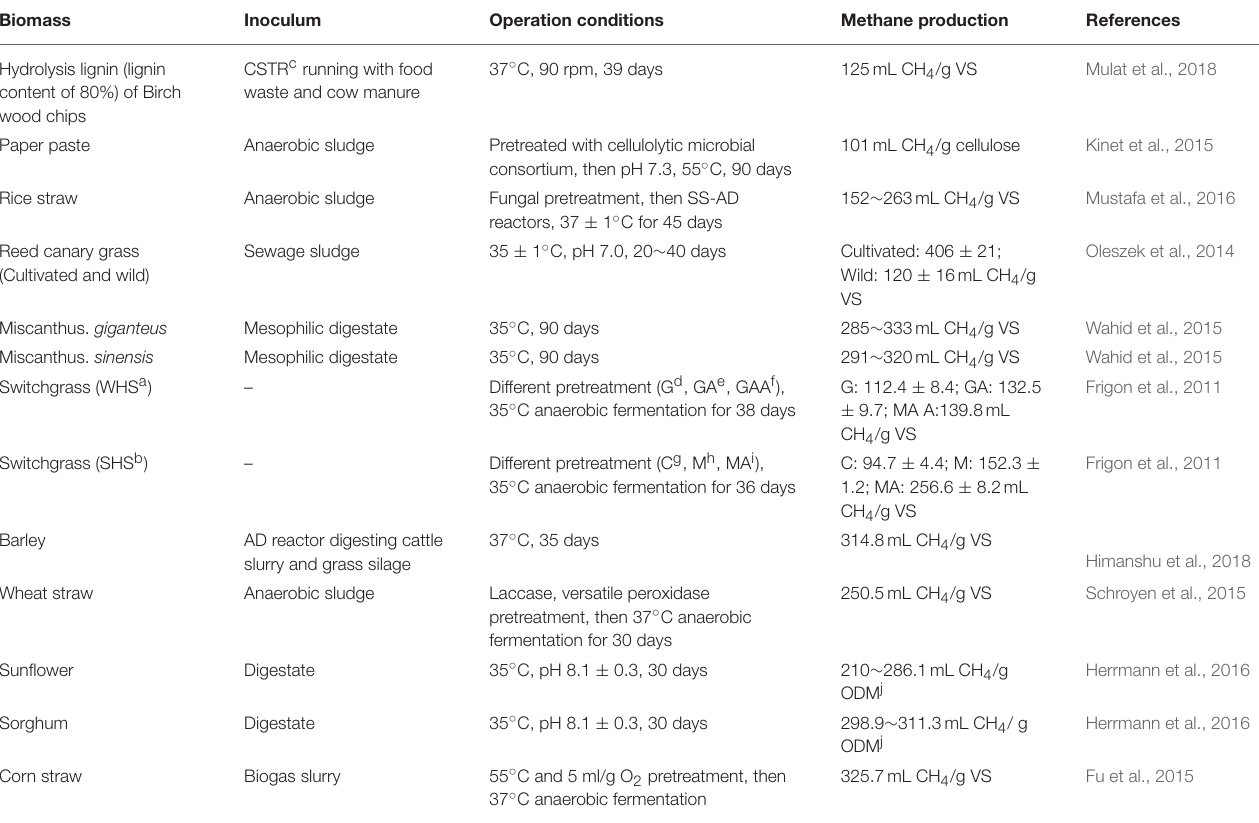
TABLE 1 | Biomethane production of selected lignocellulosic